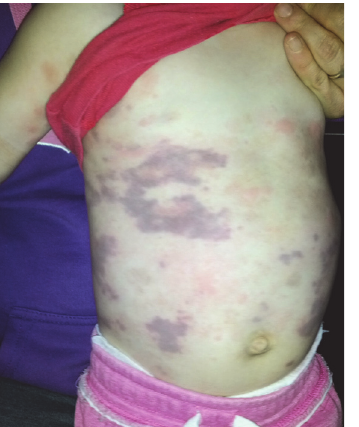
Figure 1: Widespread urticarial rash with overlying blotchy, palpa- ble purpuric